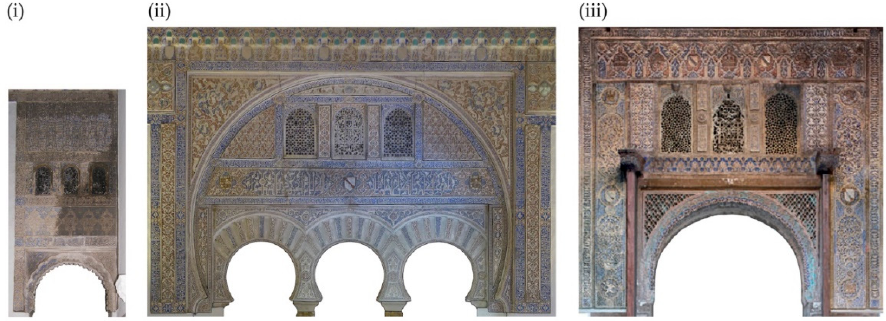
Figure 2. Plasterworks studied in this work: ( i ) Secondary entrance to the Courtyard of the Maidens [6.30 m 2 ], ( ii ) Entrance to the Hall of Ambassadors through Toledanos Room [30.50 m 2 ], and ( iii ) Entrance to the Room of the Carlos V ceiling [21.60 m 2 ].